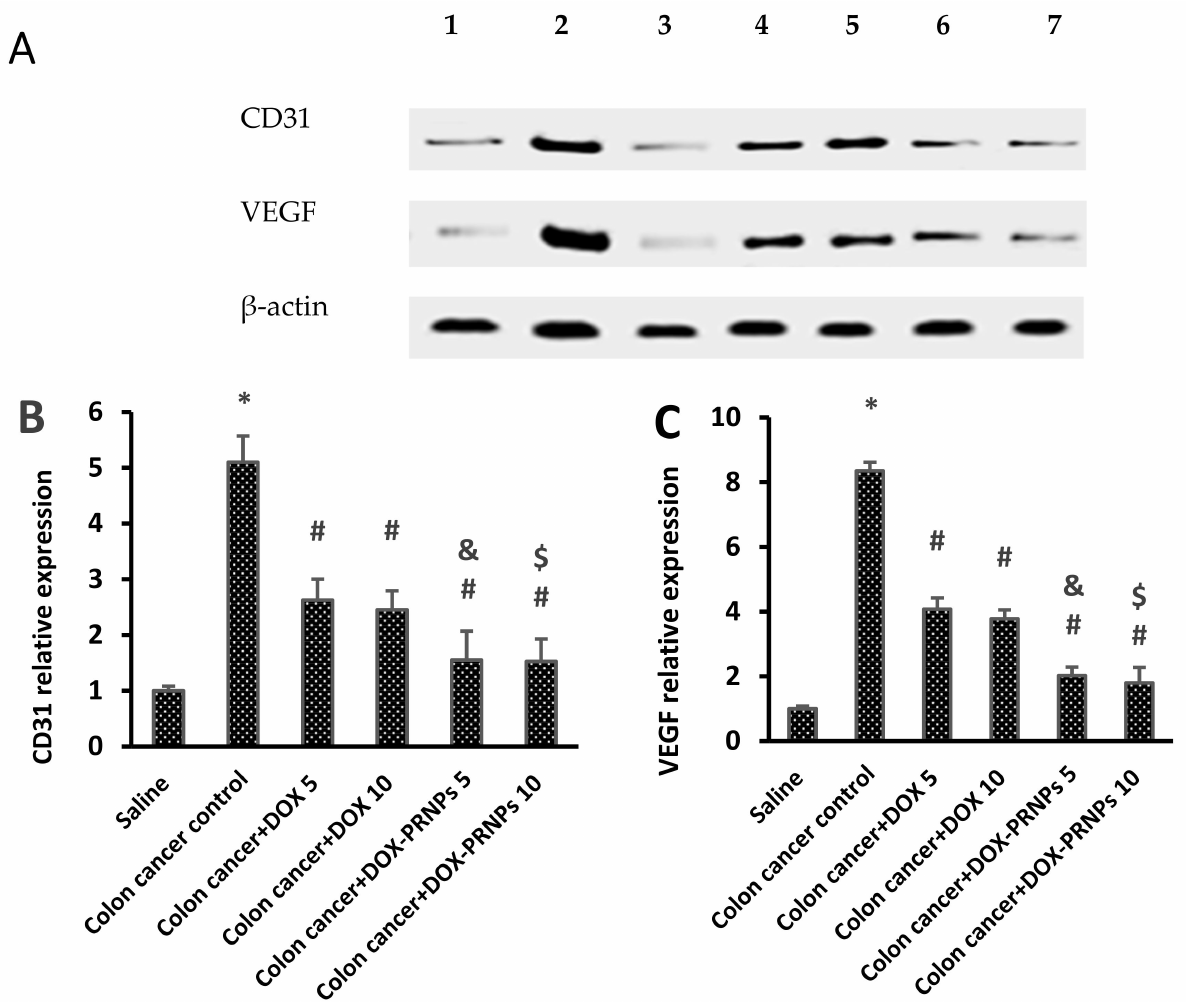
Figure 10. Western blotting for VEGF and CD31 in colon cancer model. ( A ) Western blots for CD31, VEGF and β -actin protein. 1: saline, 2: Di-MH, 3: saline, 4,5: Di-MH + DOX (5 and 10) mg/kg, 6,7: Di-MH + DOX-PRNP2 (5 and 10) mg/kg. ( B , C ) Column charts for mean ± SDM for den- sity of CD31 and VEGF. *: versus saline group, #: versus colon cancer control, &: versus colon cancer + DOX 5 mg/kg and $: versus colon cancer + DOX 10 mg/kg, p < 0.05. PRNPs: